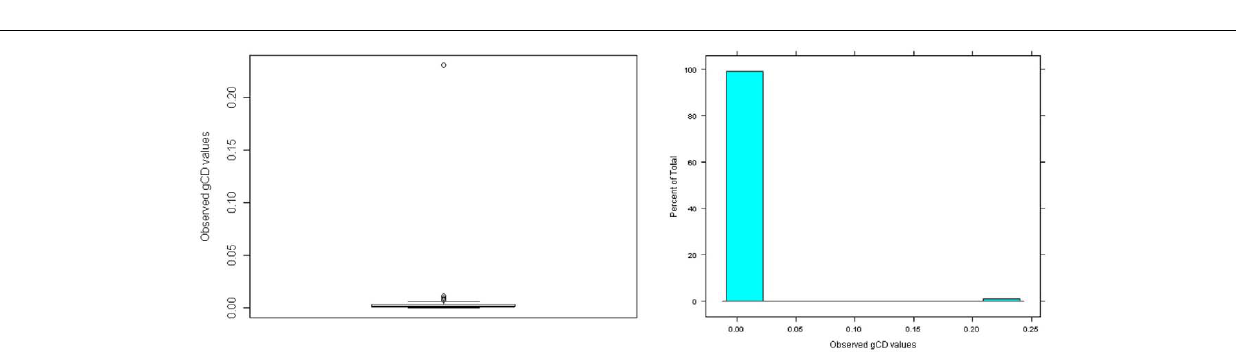
FIGURE 8 | Distribution of generalized Cook’s distance (gCD) for perturbed sample data ( N =